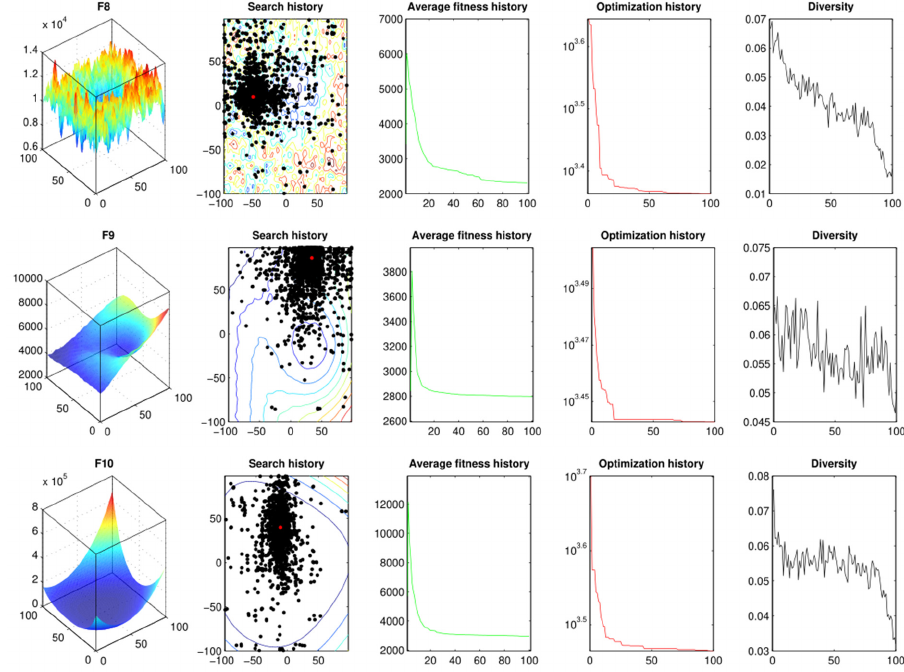
Figure 3. The qualitative metrics on the CEC’20 test suite have been obtained by the proposed mAHA.